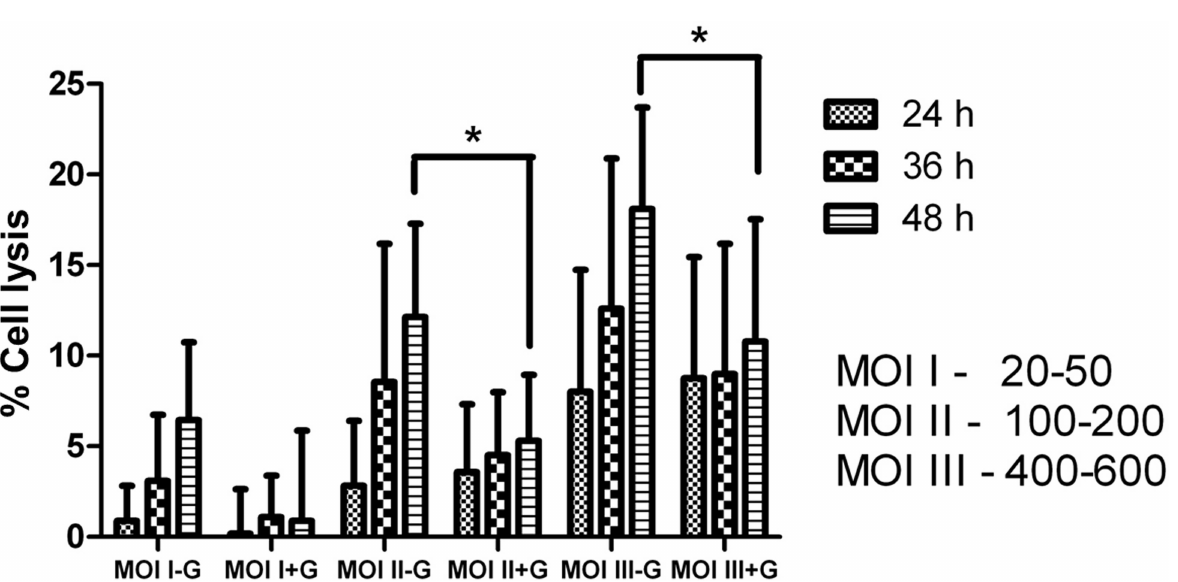
Fig 5. Percentage of cell lysis in M . agalactiae -infected HeLa cells. Both time- and dose- dependent increase ( p < 0.05) was observed at 36 and 48 h p.i. with all tested MOIs compared to uninfectedcells in absence of gentamicin. A significant decrease in cell lysis was observed in gentamicin-treated cells (+G) compared to gentamicin-untreated cells (-G) at 48 h p.i. (‘ * ’ indicates p < 0.05).